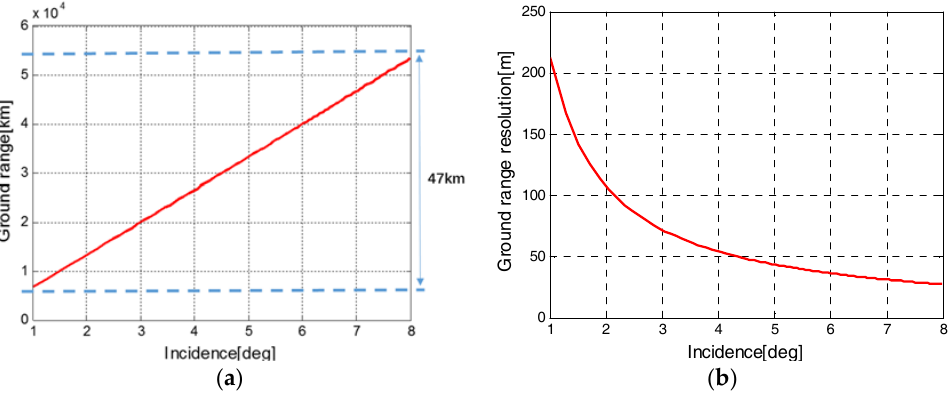
Figure 2. ( a ) Swath width and ( b ) ground ‐ range resolution of InIRA within the incidence range.